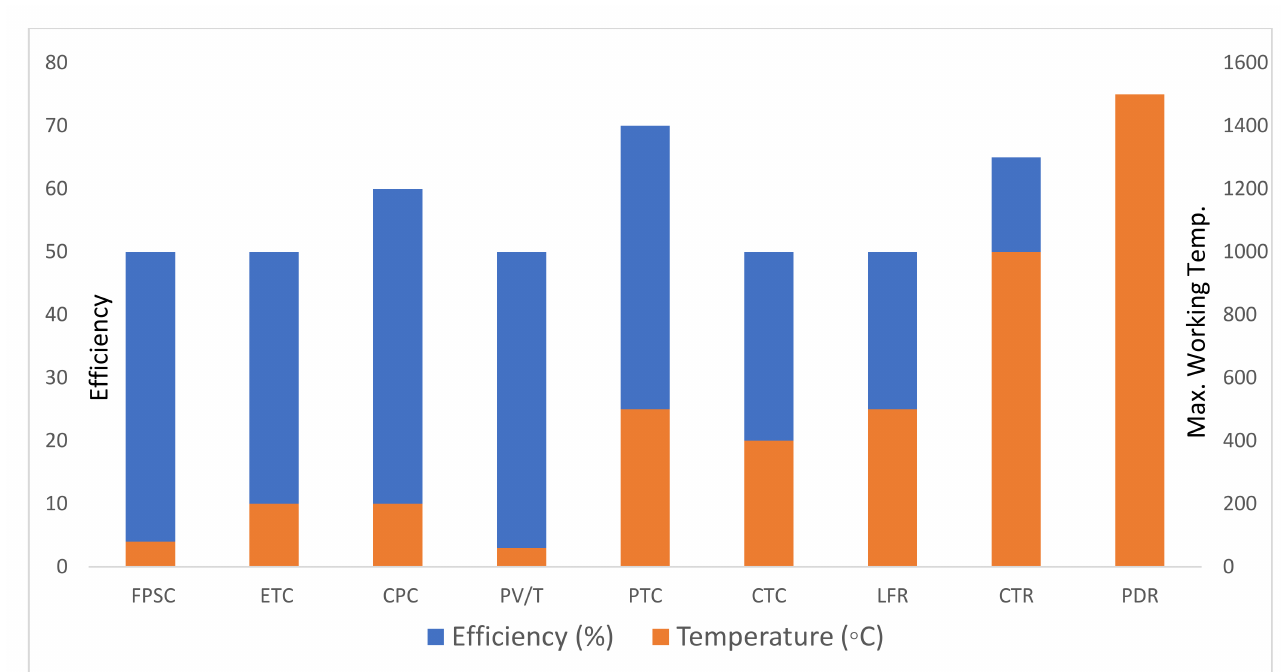
Figure 2. Efficiency and working temperatures of various STCs